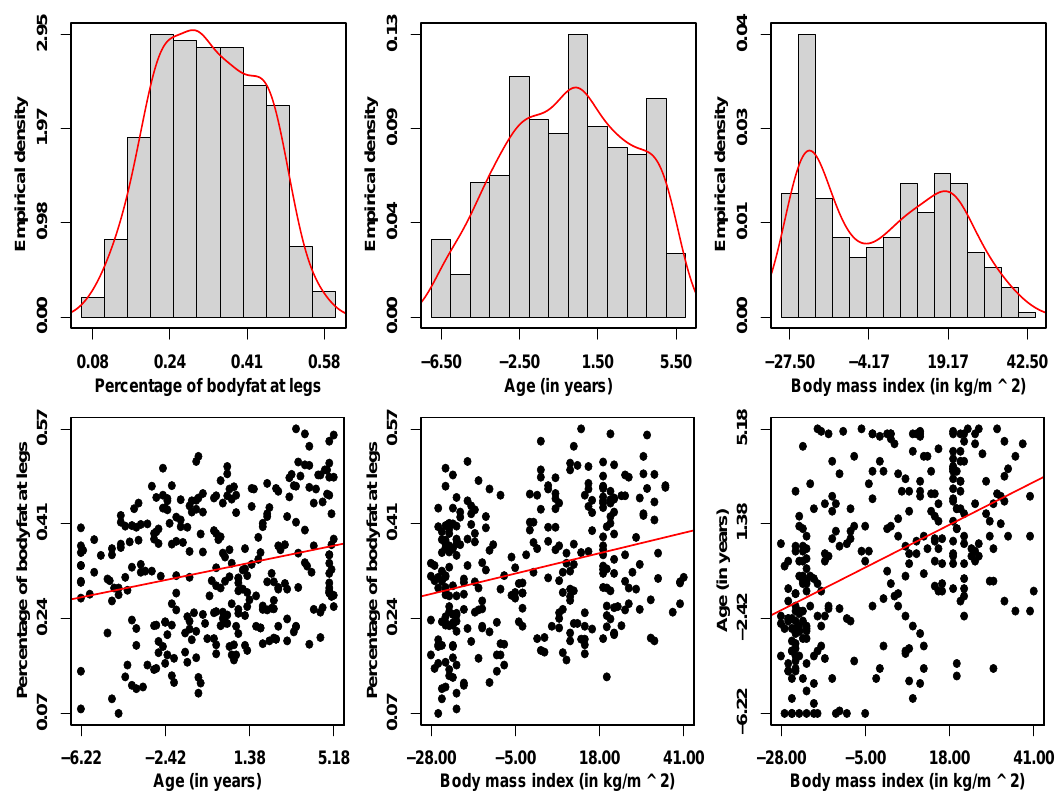
Figure 1. Scatterplots and histograms for the body fat in the legs data